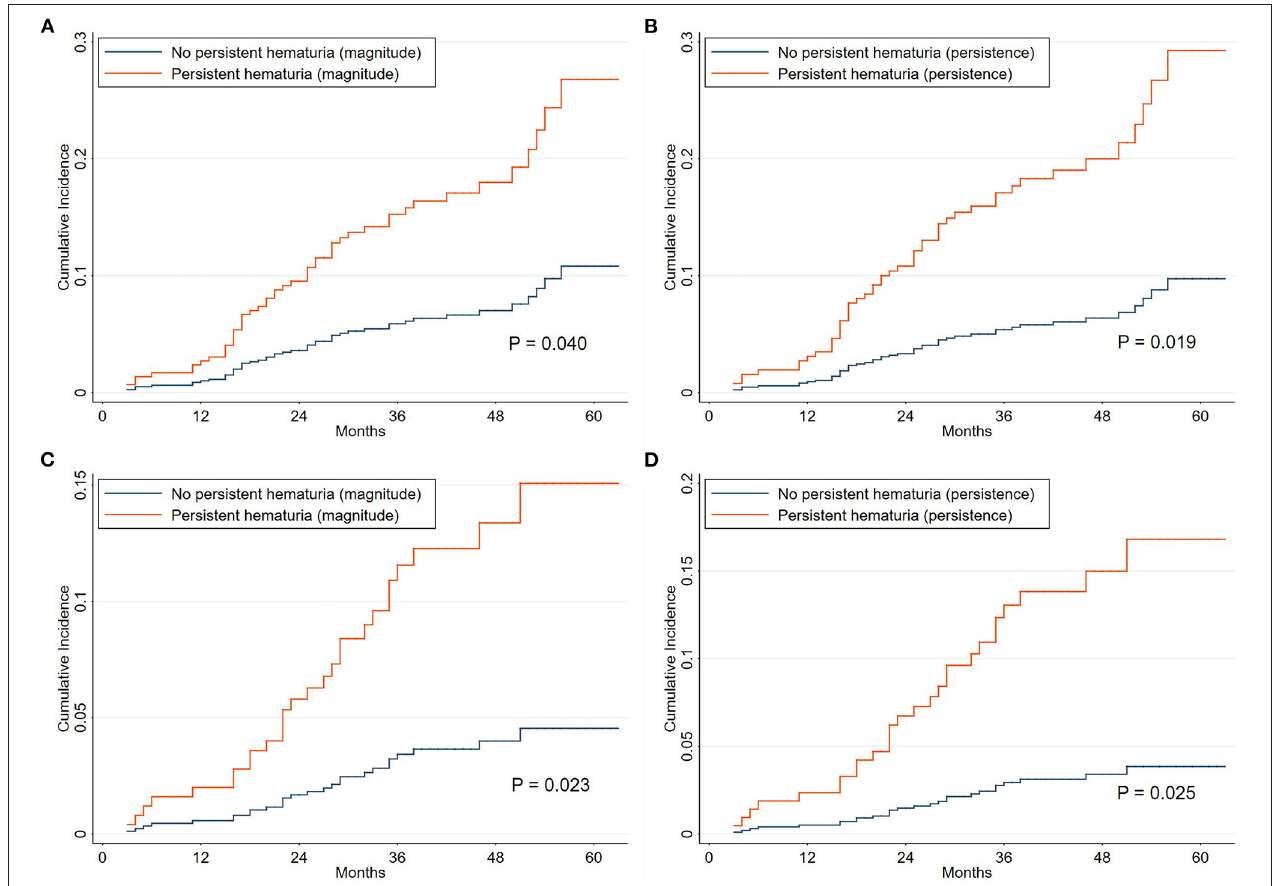
FIGURE 3 | Cumulative incidence curves for composite renal progression events grouped by hematuria classification. The cumulative incidence function methods and Gray test were used for analyses. The time zero was kidney biopsy. According to the magnitude of microhematuria over time, the persistent hematuria was defined as time-averaged hematuria > 5 RBCs/HPF (A,C) . As for the persistence of microhematuria, the persistent hematuria was defined as cumulative duration of hematuria > 12 months (B,D) . The corresponding endpoints were 40% decline in renal function or end-stage renal disease (A,B) and 50% decline in renal function or end-stage renal disease (C,D) . Death without renal progression was treated as a competing event.